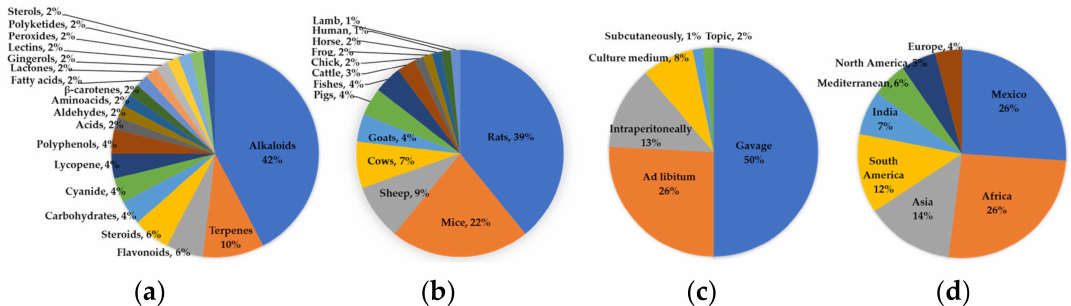
Figure 2. Graphic summary of the most relevant data obtained in the documentary research. ( a ) Abun- dance of the families of compounds identified in the teratogenic plants analyzed; ( b ) percentages of the main animal species (models) used to evaluate the teratogenicity of plants in the collected studies; ( c ) main routes of administration utilized in the evaluation of teratogenicity in the studies consulted, and; ( d ) distribution of identified teratogenic plants, native to or introduced from other